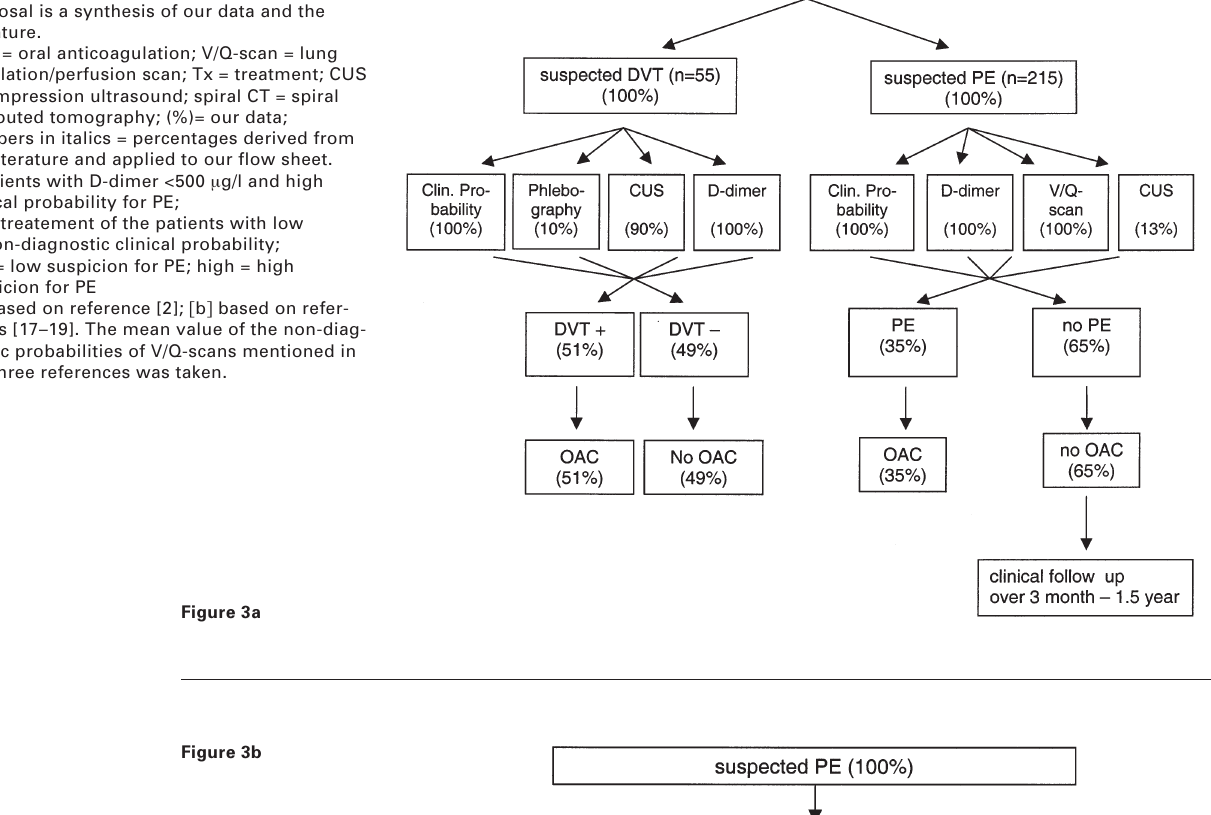
Figures 3 a and 3b show the former and a new proposed diagnostic procedure for PE, our proposal is a synthesis of our data and the